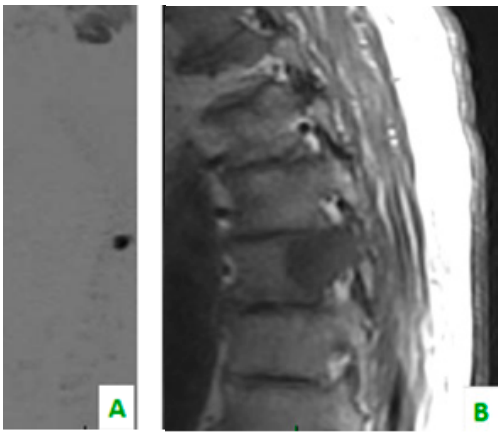
Figure 1. ( A ) Diffusion-weighted imaging (DWI) sequence in sagittal plane shows focal alteration of diffusivity. ( B ) The sagittal plane of TSE T1 shows, in the same level, a hypointense region of the dorsal soma related to the secondary localization of prostate cancer.